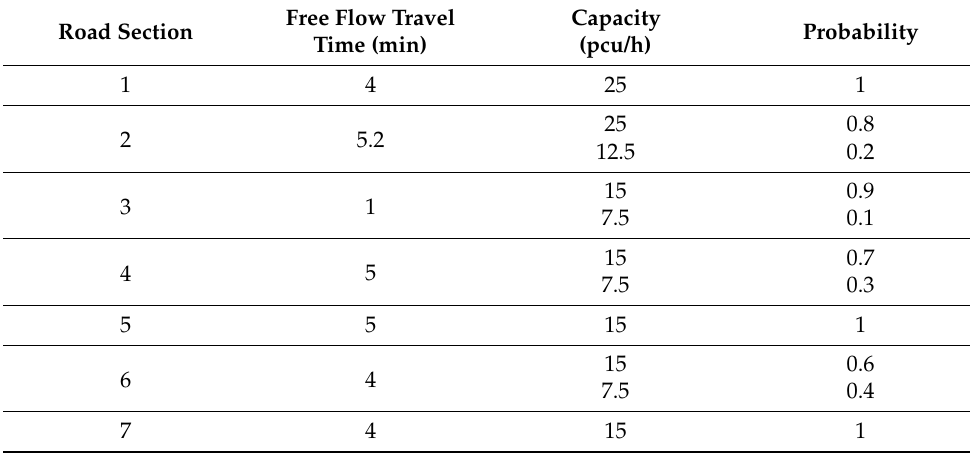
Table 2. State probability of different road network capacity.